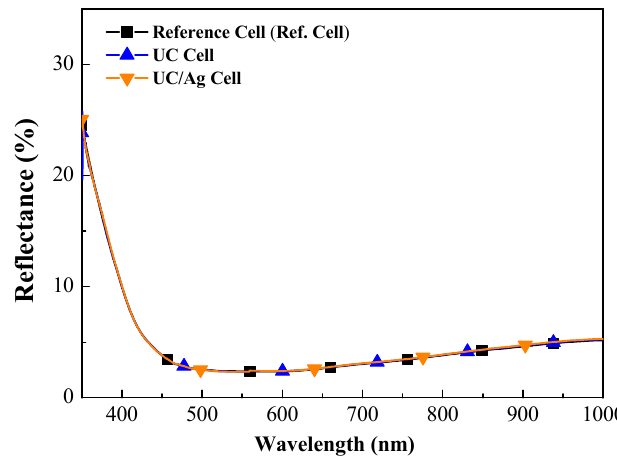
Figure 9. Optical reflectance of reference solar cell, UC cell, and UC/Ag cell.